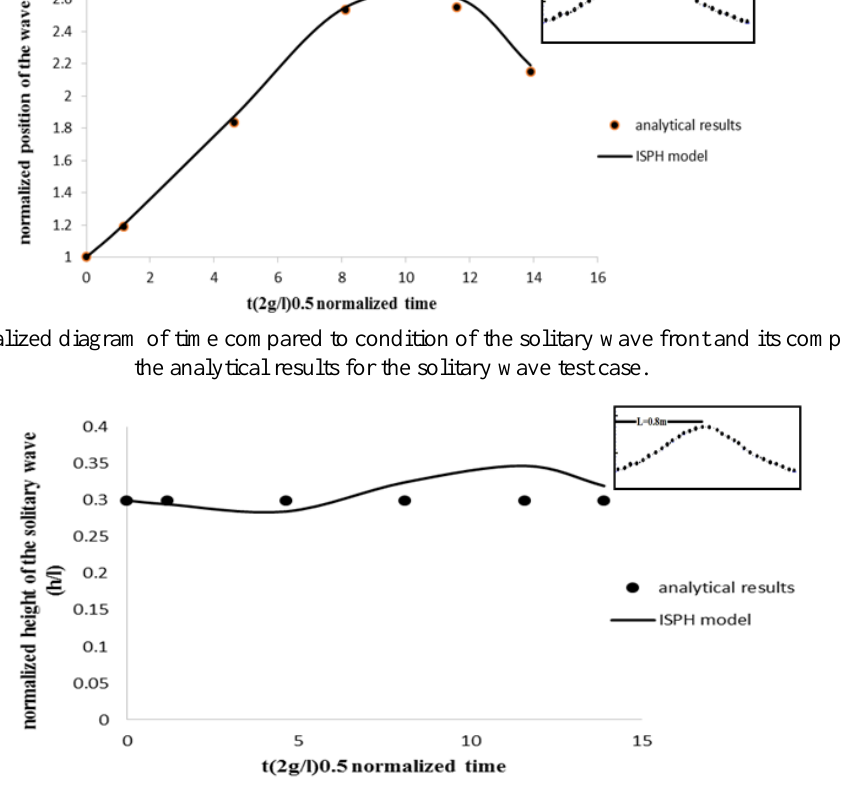
Figure 13 Normalized diagram of time compared to height of the solitary wave and its comparison with the analytical results.